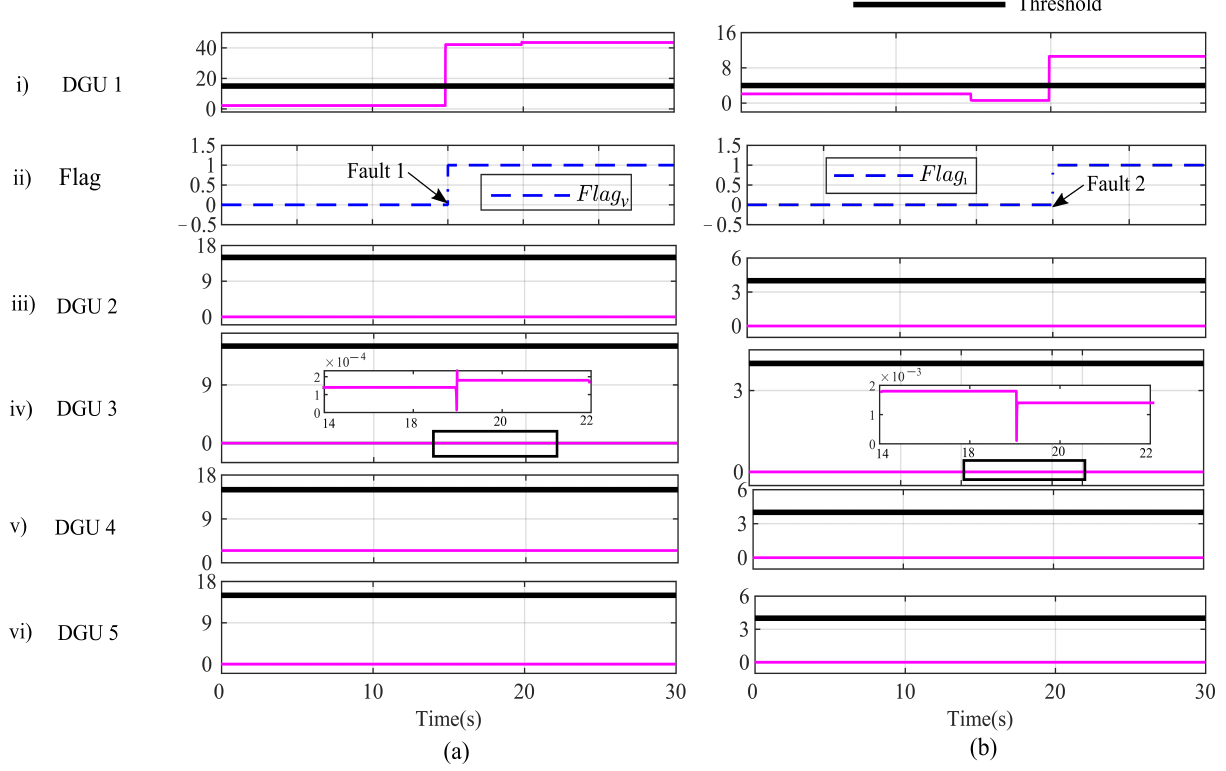
= − 0.5. ( a ) Voltage residuals of i